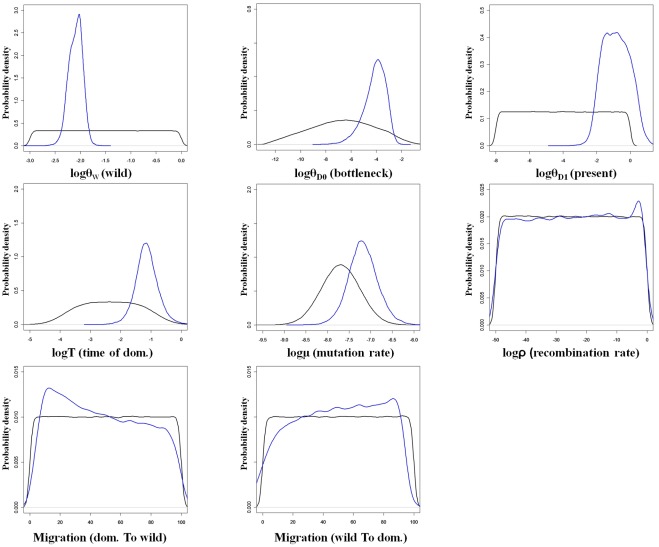
Posterior probability density distribution of the parameters of the demographic model inferred by ABC estimation.Data shown was obtained for the scenario “with migration”. The prior (black line) is used as a reference for the posterior distribution (blue lines) obtained from the rejection followed by the non linear regression. Parameters T, M and rho are scaled to the wild population effective size New.